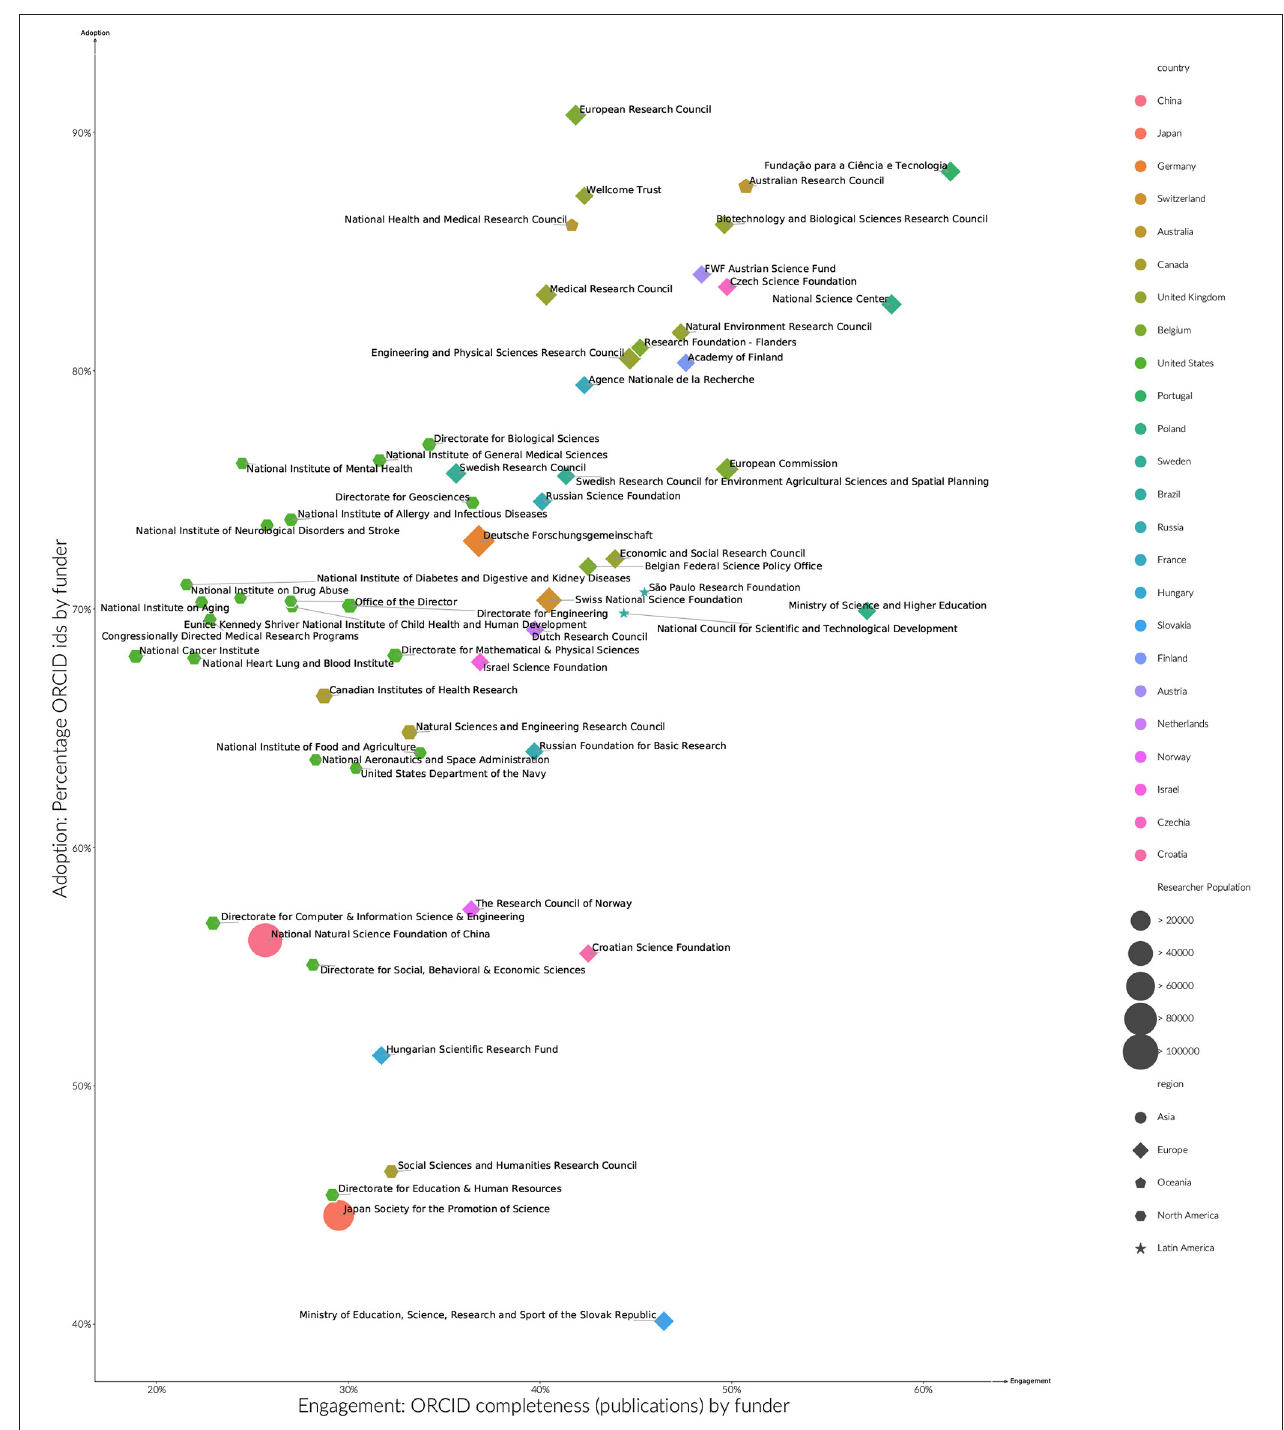
FIGURE 5 | Estimated ORCID adoption and engagement by funder researchers > 5 years publication history, publications (2015–2019). Sizes indicate the number of researchers by funder, with shapes denoting world regions. To aid readibility of funder names, axis do not start at